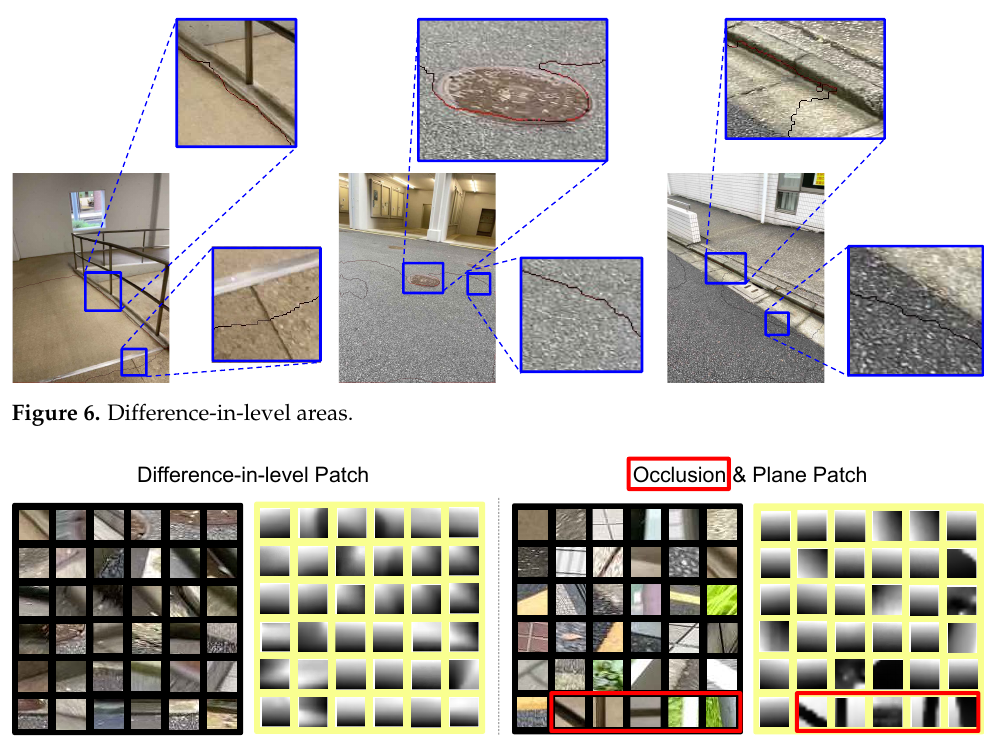
Figure 7. Example patch images of the dataset.